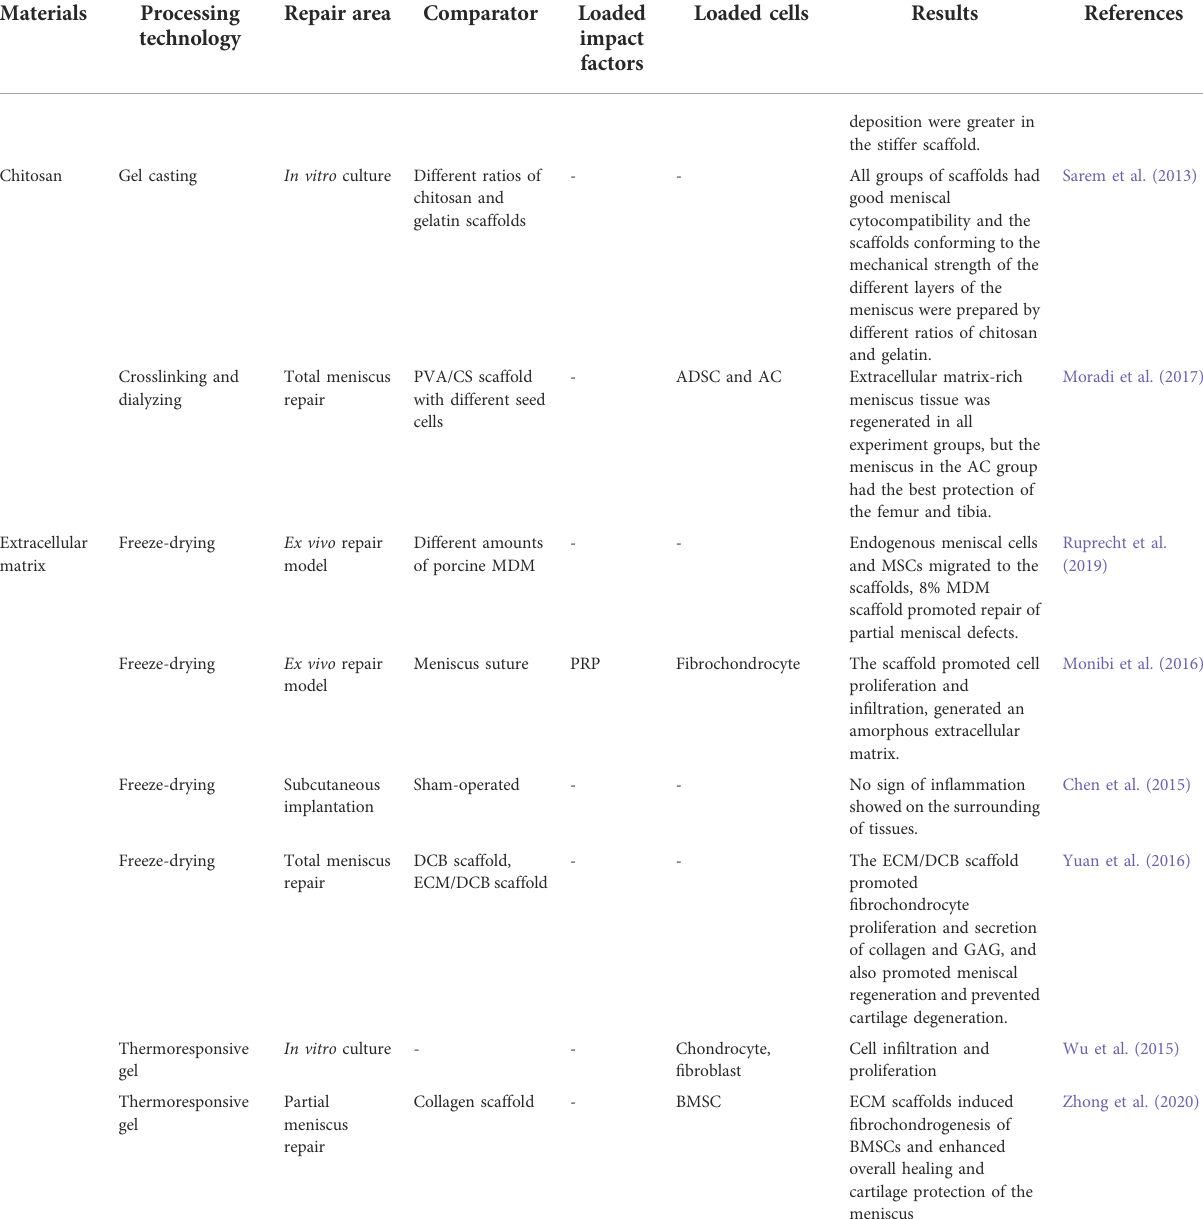
considered to have repair potential with meniscal